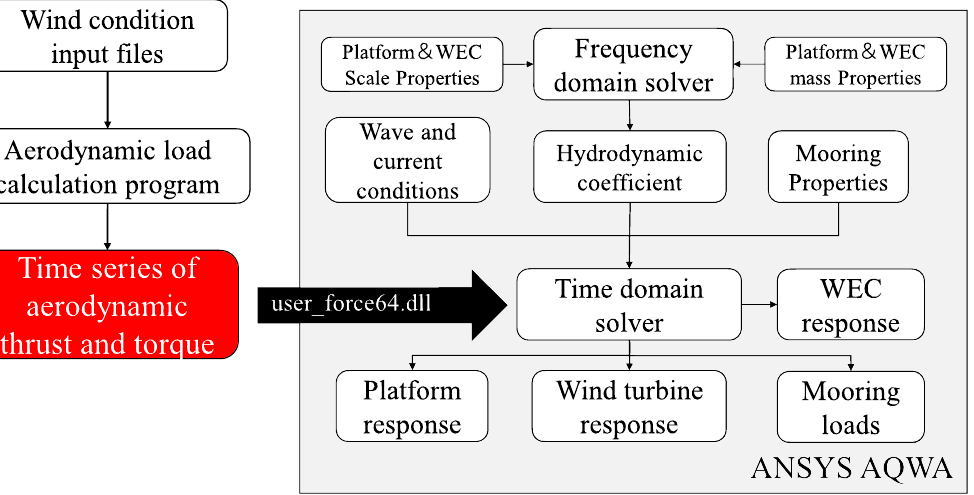
Figure 11. Schematic diagram of wind-wave coupling simulation flow by using dynamic link library in ANSYS